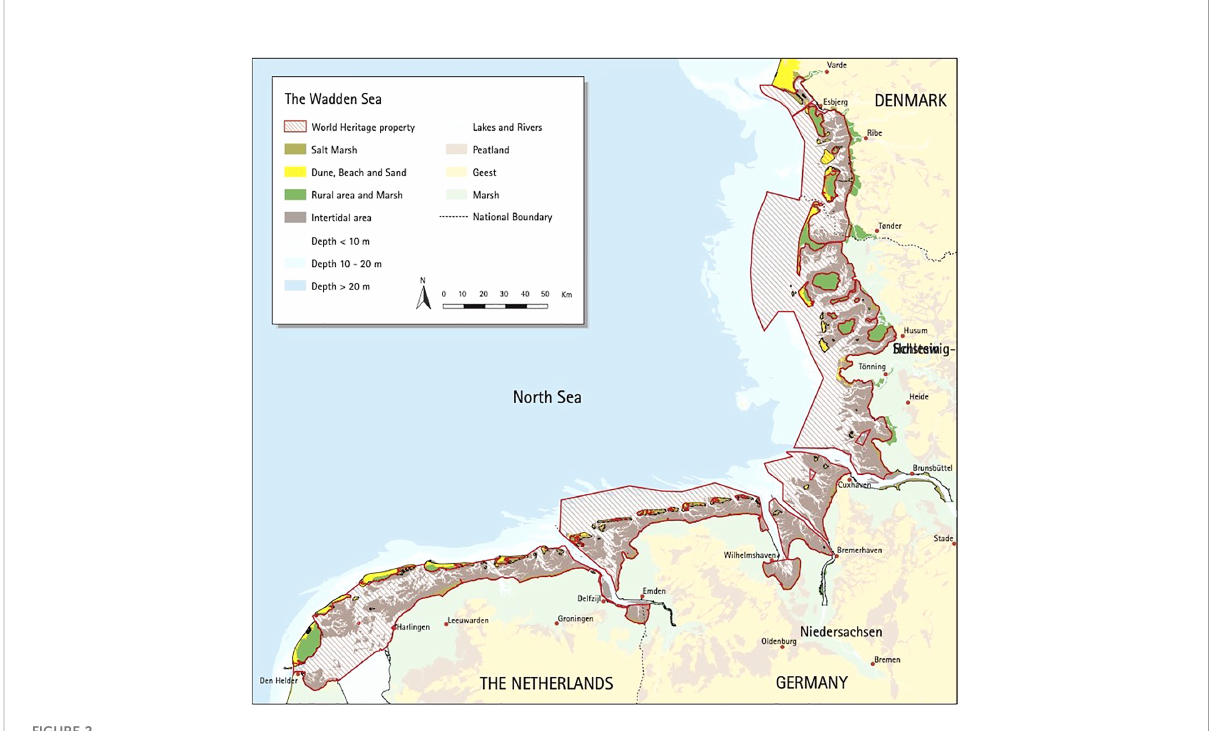
FIGURE 2 Map of the Wadden Sea. Source: UNESCO, World Heritage Center,